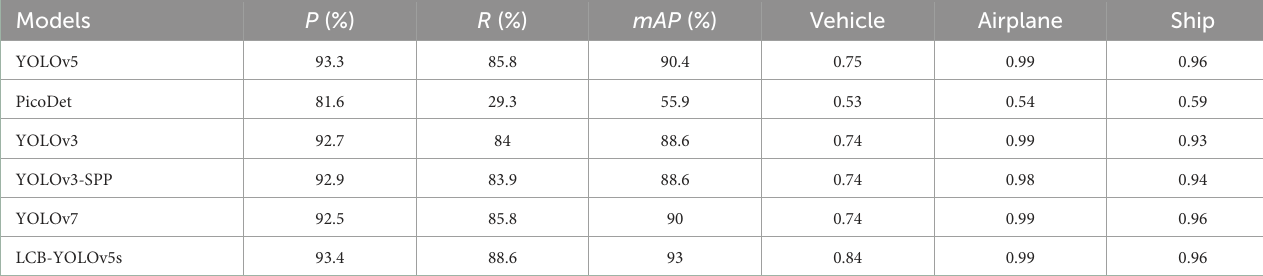
TABLE 4 Comparison of the proposed method with other approaches based on the DIOR-VAS dataset.